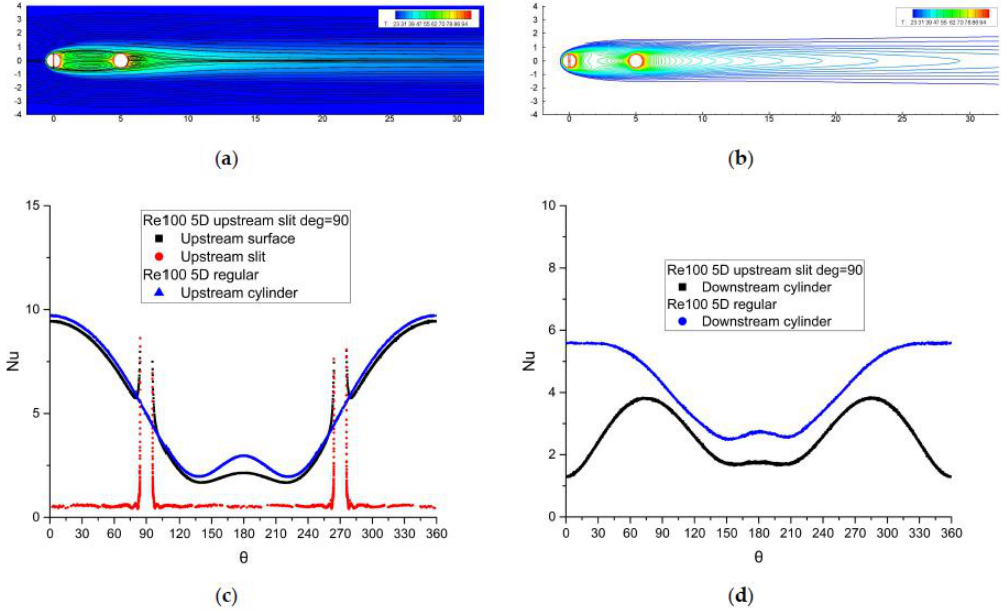
Figure 17. Re = 100, L/D = 5 with slit α = 90° and ( a ) streamlines, ( b ) temperature contours, ( c ) time mean Nusselt number distribution of the upstream cylinder in regular and slotted array, and ( d ) time mean Nusselt number distribution of the downstream cylinder in regular and slotted array.